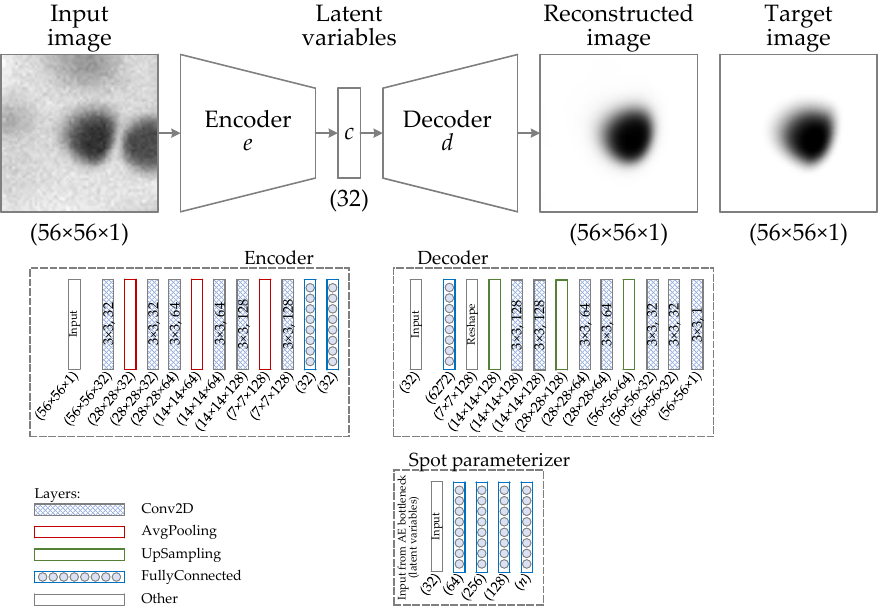
Figure 7. Structure of the protein spot reconstruction algorithm. The autoencoder (AE) is the core part of the algorithm. In addition to the AE, there is a separate branch for the prediction of spot parameters from the bottleneck features (spot parameterizer). In this experiment, the spot parameterizer predicts the peak intensity and integrated intensity of the spot ( n = 2). Configurations of the encoder, decoder, and parameterizer are presented in blocks framed by the dashed line, showing the number of filters and kernel sizes of the convolutional layers, the number of units in dense layers, and the output shapes of all the layers. The loss of the current model has two components: mean absolute error (MAE) of spot reconstruction and MAE of spot parameter